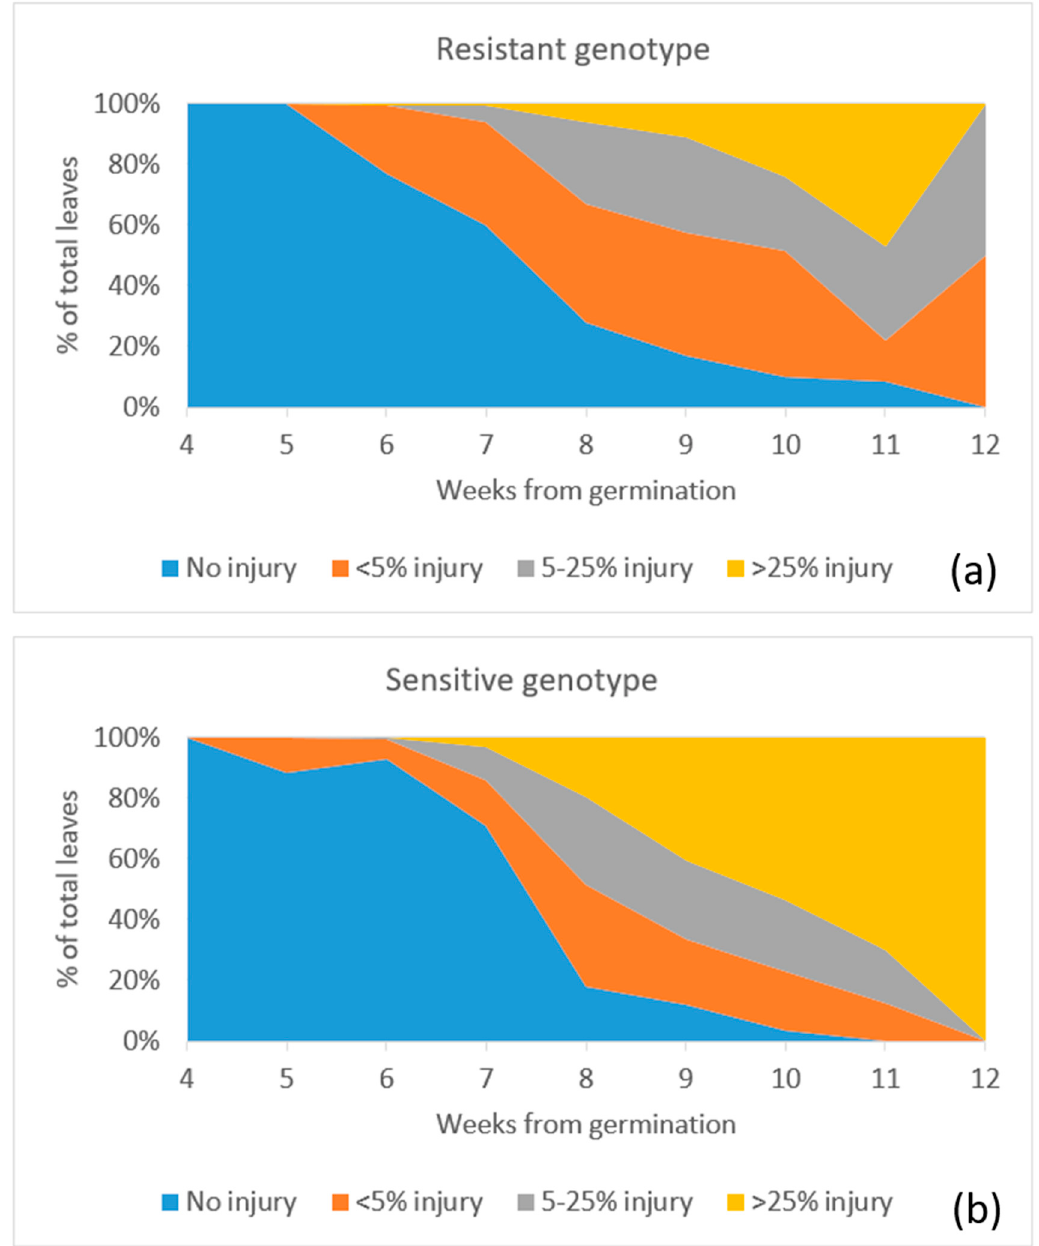
Figure A4. Percentage of O 3 -induced visible foliar injury according to the injury index from germination to harvest for resistant ( a ) and sensitive ( b ) genotype of Phaseolus vulgaris . The date of the first week is 4 January 2019 and the fourth week is 19 February 2019.